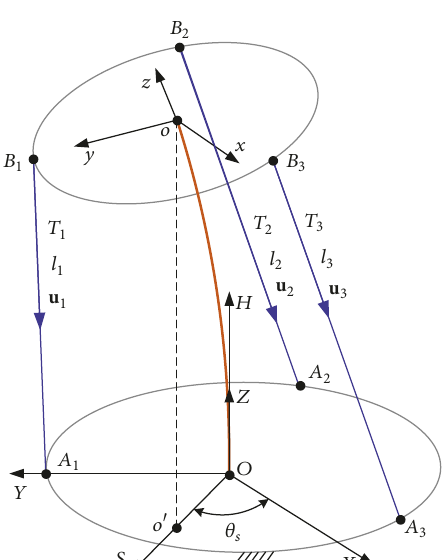
Figure 5: Architecture of the control system.